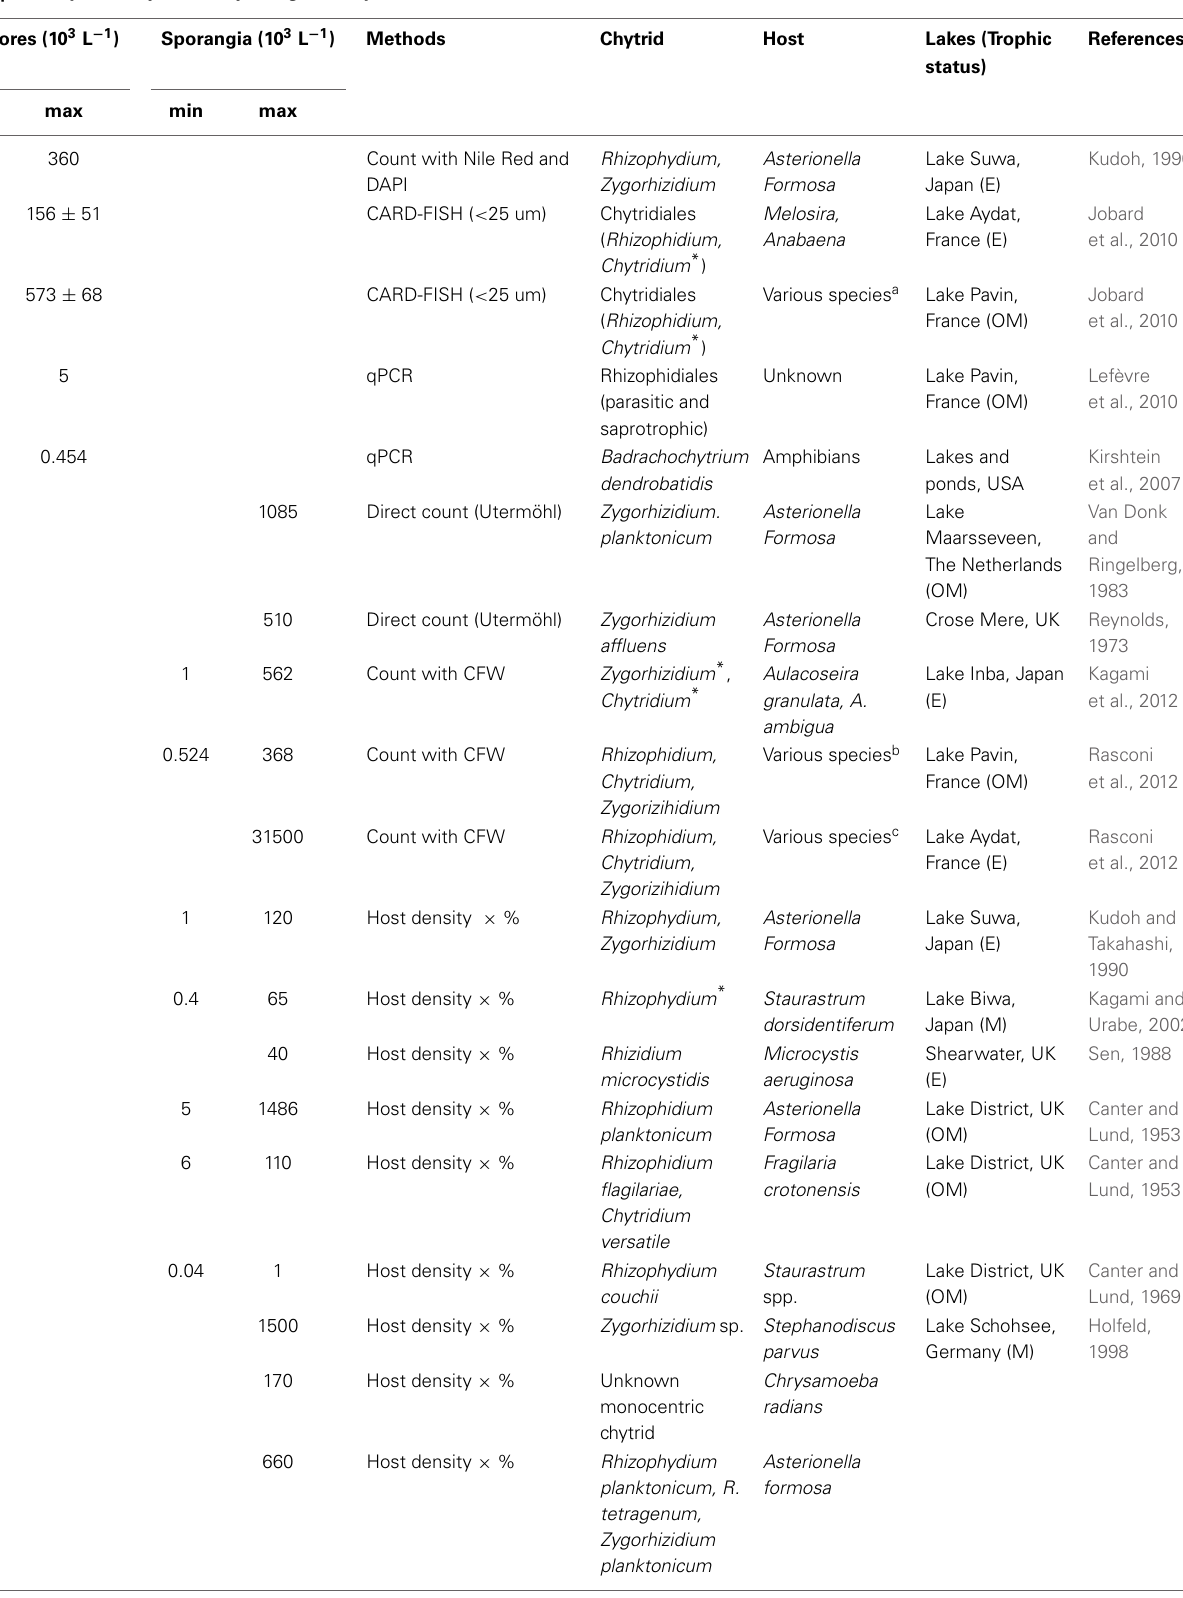
Table 1 | Density of zoospores or sporangia of chytrids in lakes. Zoospores (10 3 L − 1